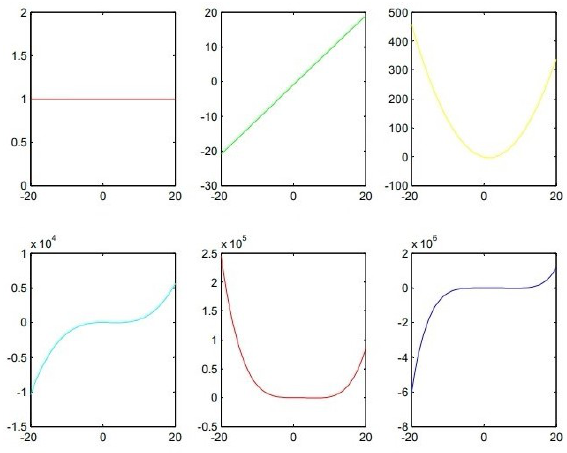
Figure 1. Polynomials of the Example 1.